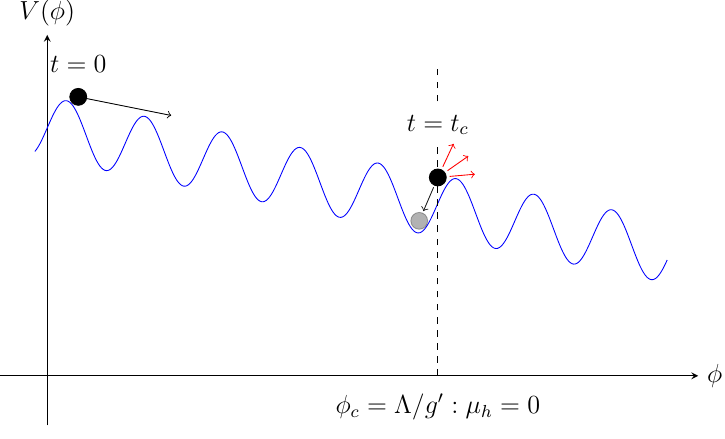
Figure 1 . Sketch of the relaxion (cid:12)eld